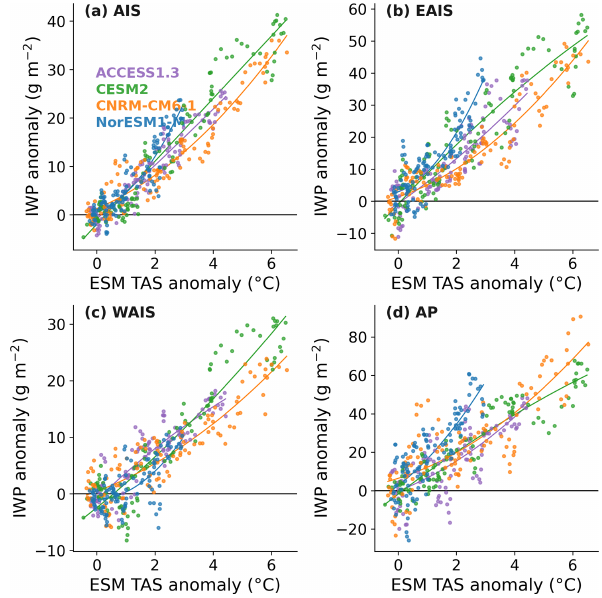
Figure 7. Changes in mean summer liquid water path (gm − 2 ) as projected by MAR forced by ACCES1.3 (purple), CESM2 (green), CNRM-CM6-1 (orange), and NorESM1-M (blue) for all the Antarctic ice shelves (a) and the ice shelves of the East Antarc- tic sector (b) , the West Antarctic sector (c) , and the Antarctic Penin- sula (d) compared to mean summer ESM near-surface temperature ( ◦ C) over 90–60 ◦